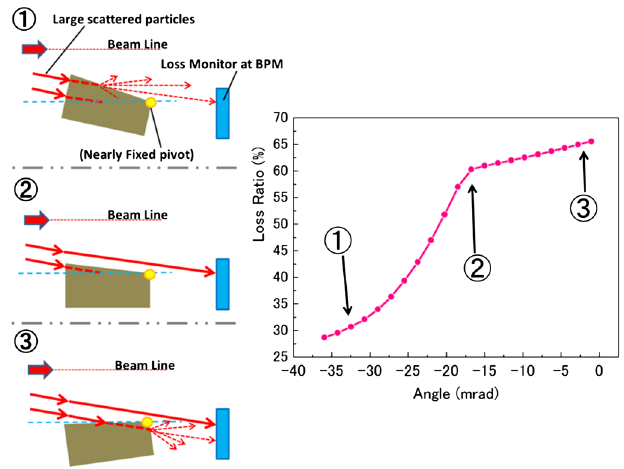
FIG. 8. Details of the LMM. The left figures show schematics of the rotation of the absorber placed on the inside of the ring. The right figure shows the loss dependence on the absorber rotation at the inside of the